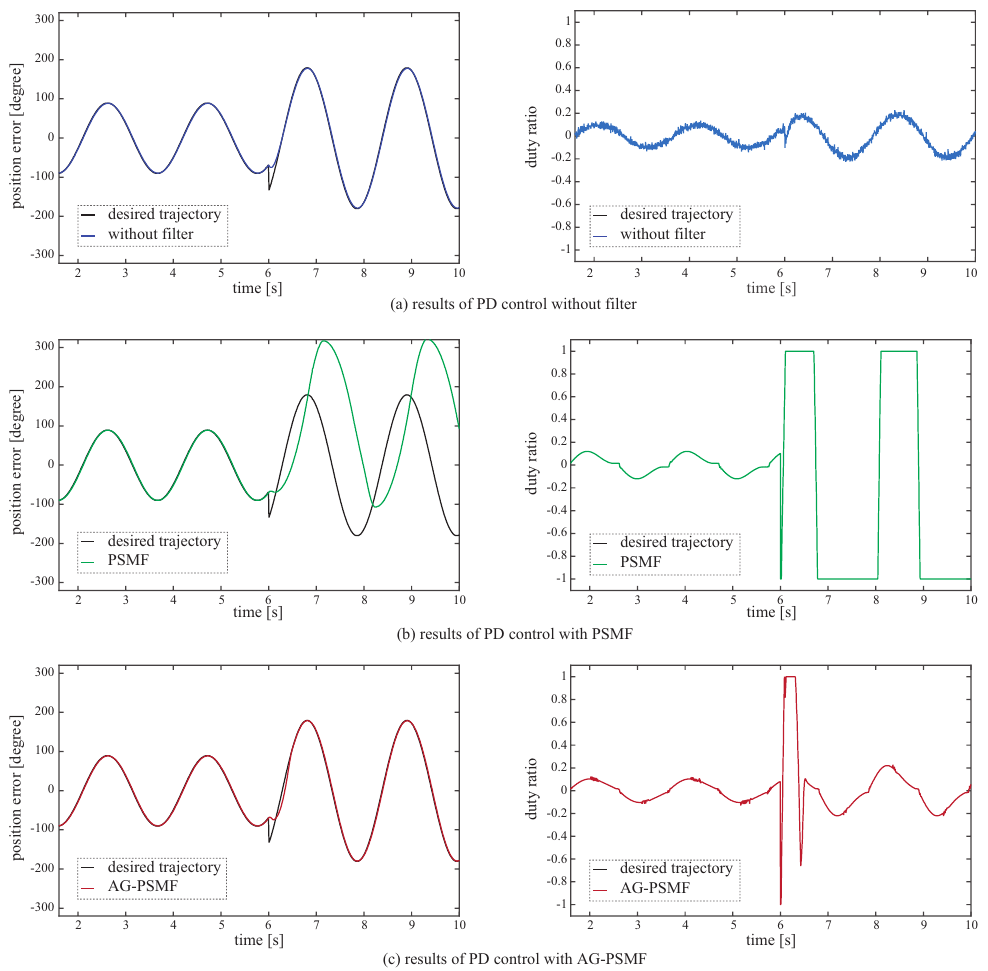
Figure 13. Results of PD control with K p = 100, K d = 10 and T = 0.001. ( a ) without filter ( b ) with PSMF ( F = 1000, H = 5), and ( c ) with AG-PSMF ( F = 1000, H = 5, N max = 10, N c = 5, R = 0.00008).